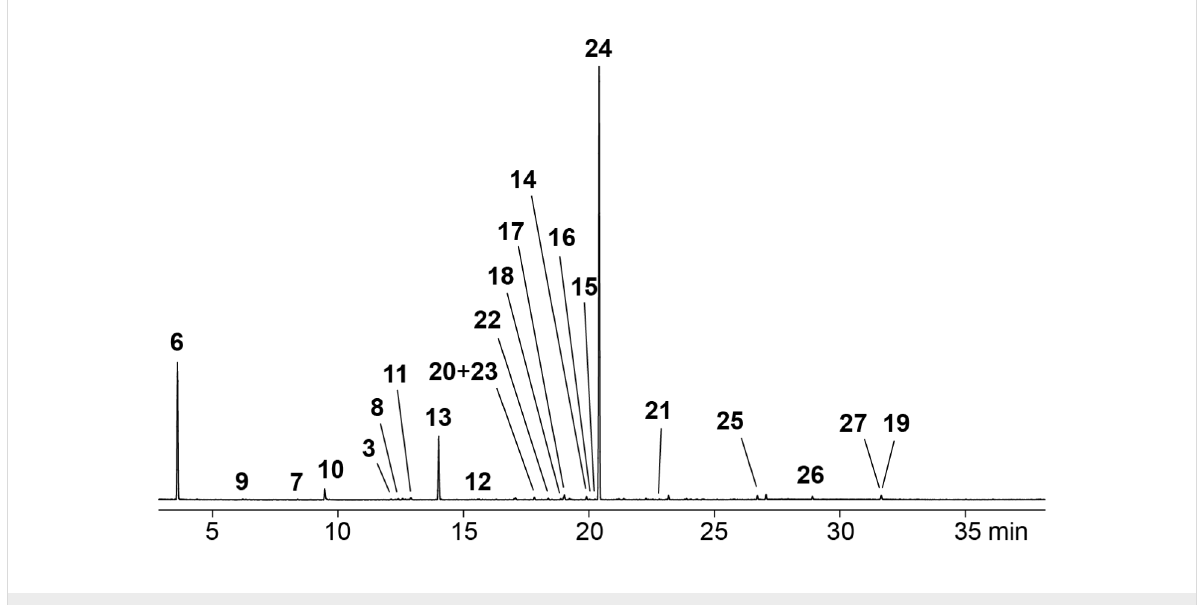
Figure 2: Total ion chromatogram of a CLSA headspace extract from Hypoxylon griseobrunneum MUCL 53754. Peak numbers refer to compound numbers in Table 1 and in Figure 3.